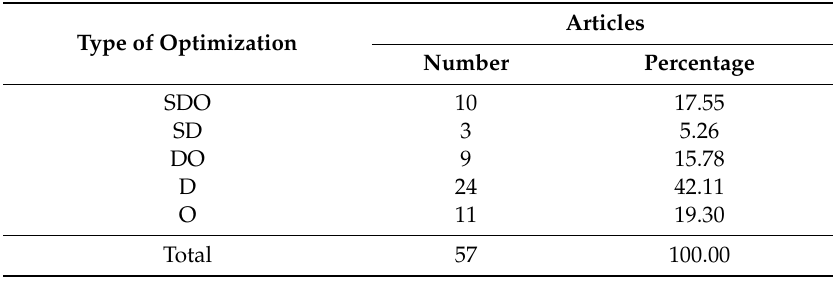
Table 2. Type of optimization and number of